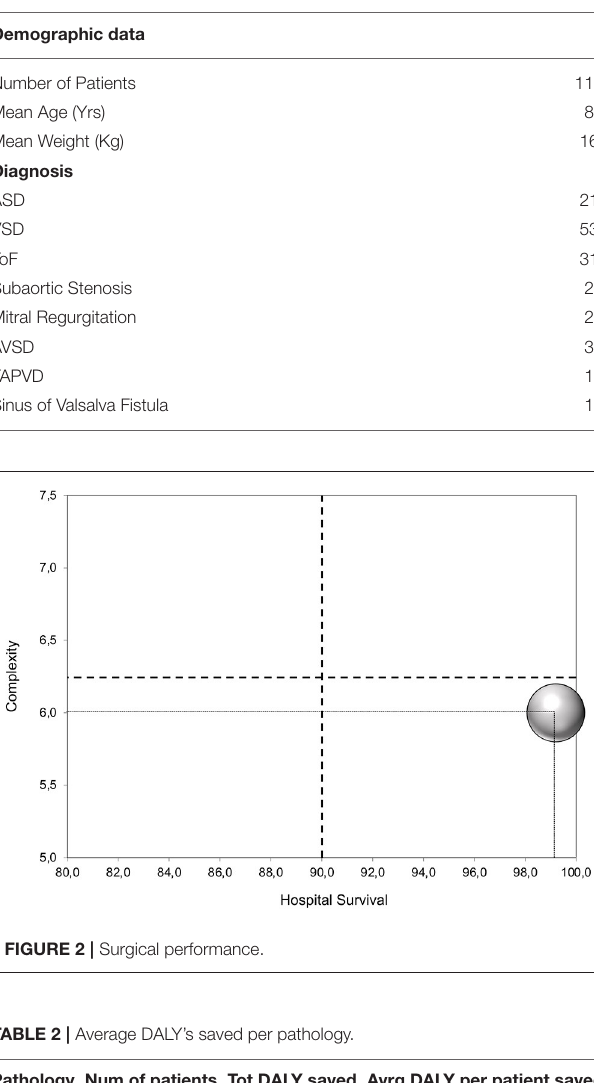
TABLE 1 | Demographic data.